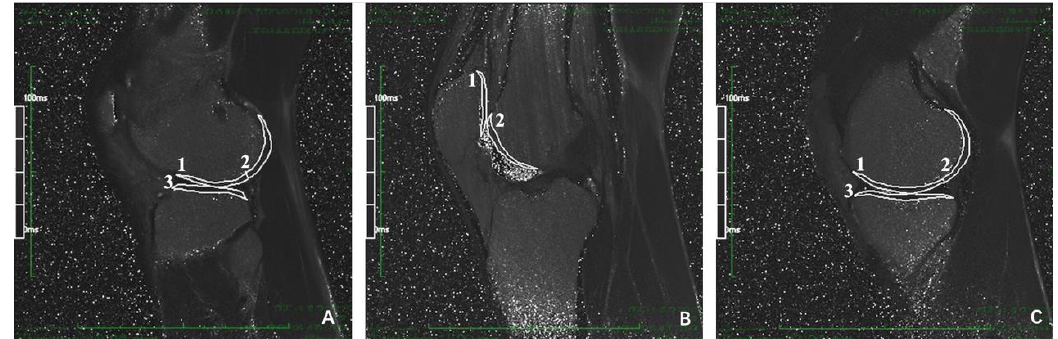
Figure 4. Measurements of T2 value of cartilage in each sub region of knee joint. ( A ) the lateral tibiofemoral joint of the knee: the measurement sub zone 1 is the aLFC, the measurement sub zone 2 is the pLFC, and the measurement sub zone 3 is the LT; ( B ) patellofemoral joint of knee joint: the measurement sub zone 1 is P, and the measurement sub zone 2 is TrF; ( C ) medial tibiofemoral joint of knee joint: the measurement subzone 1 is aMFC, the measurement subzone 2 is pMFC, and the measurement subzone 3 is